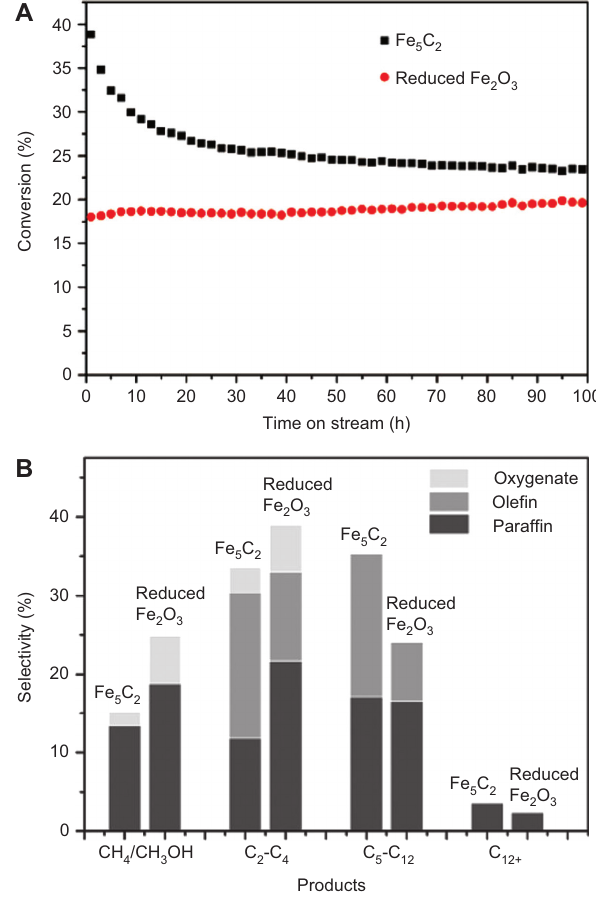
C NPs/SiO and 5 2 2